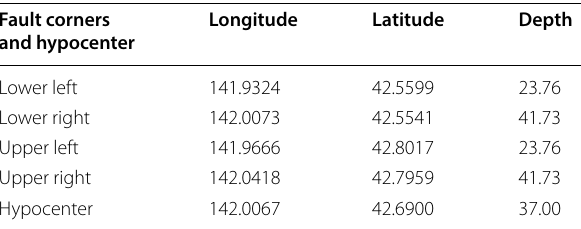
The earthquake was followed by many aftershocks, which concentrated primarily on a steeply dipping fault plane. Based on the spatial and temporal distribution of hypocenters of the aftershocks, a fault plane of about 28 km in length and 20 km in width was estimated. The minimum depth to the top of the fault plane was assumed to be about 24 km. The coordinates of the fault plane are provided in Table 1. The horizontal vector peak ground accelerations (PGAs) and peak ground velocities (PGVs) recorded by K-NET, KiK-net, and JMA accelerometers are plotted in Fig. 1a, b, respectively, for the mainshock.